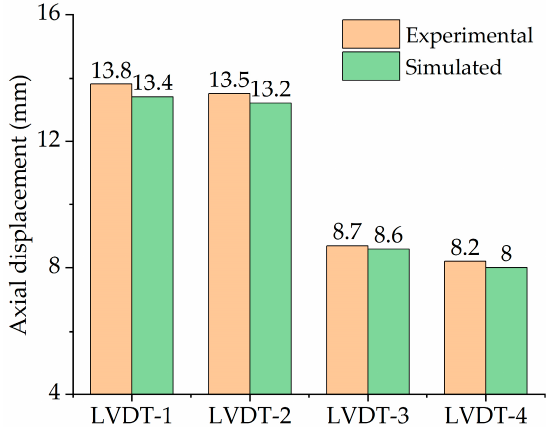
Figure 14. Axial displacement of the LTC and cable.